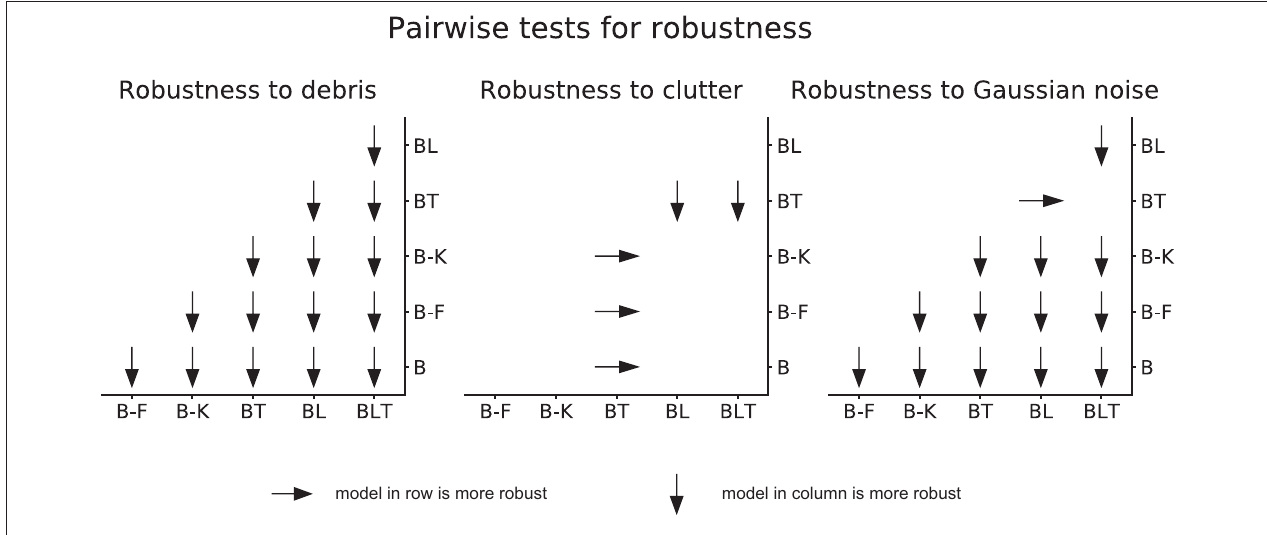
FIGURE 9 | Pairwise differences in model robustness to increased task difficulty. Arrows indicate the more robust model out of the pair